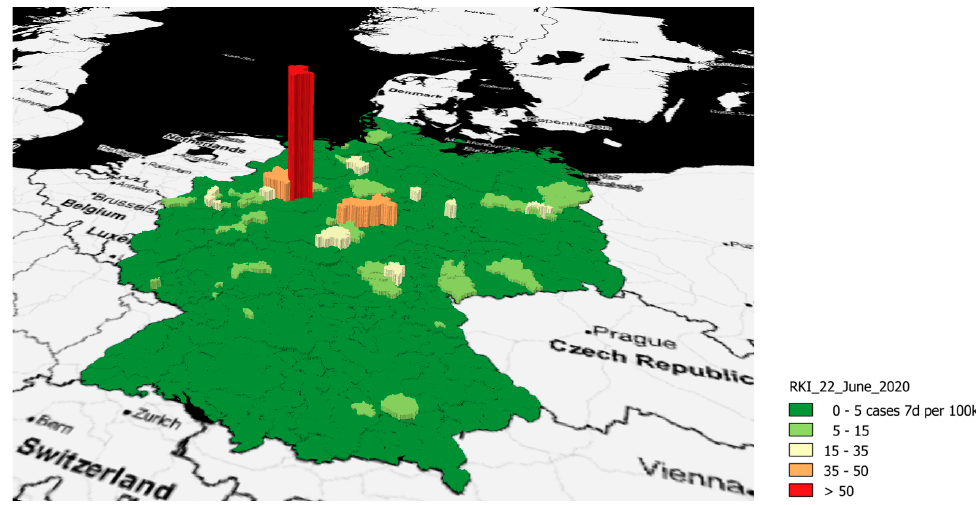
Figure 8. Visualization at NUTS 3 level of a major local COVID-19 outbreak in Germany, June 2020. (Source: own representation, data based on [29]).